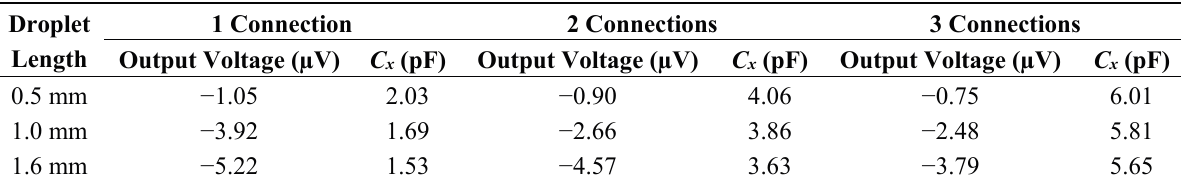
Table 3. Output voltage obtained for each droplets passing the sensor: 0.5 mm length, 1.0 mm length and 1.6 mm length; for each of the droplets, the capacitance value is determined in terms of the fitting equations in Figure 5a.